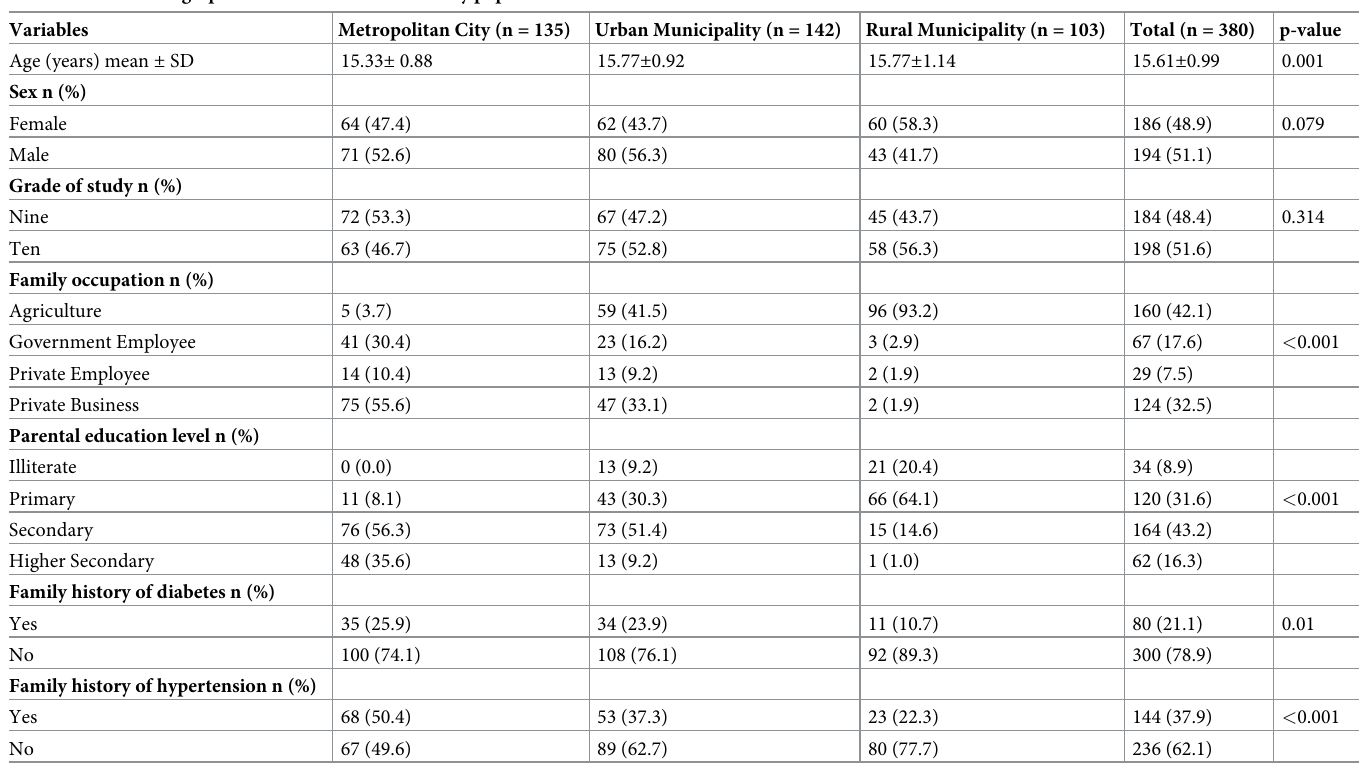
Table 2. Socio-demographic characteristics of the study